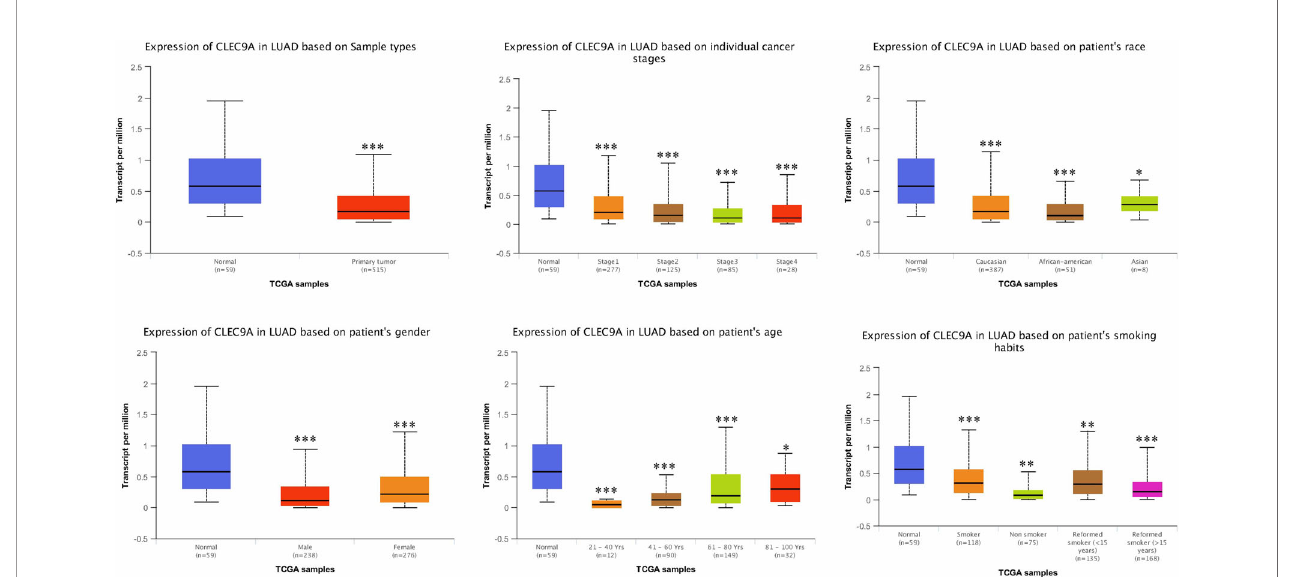
FIGURE 1 | CLEC9A expression in subgroups of patients with LUAD, strati fi ed based on gender, age, and other criteria. * p < 0.05, ** p < 0.01, *** p <